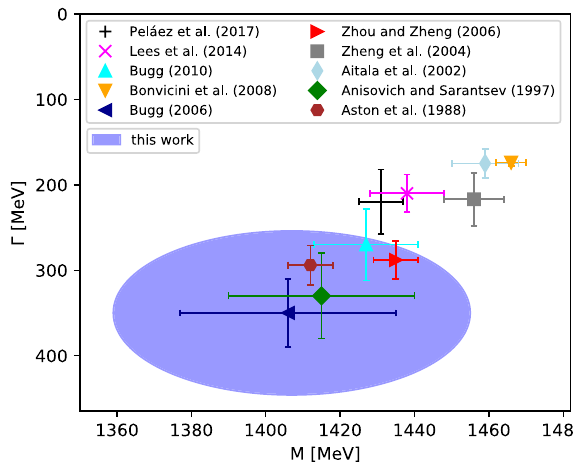
( 1430 ) in comparison to Fig. 12 Extracted pole position of the K ∗ 0 Peláez et al. [5], Lees et al. [95], Bugg (2010) [96], Bonvicini et al. [97], Bugg (2006) [98], Zhou and Zheng [94], Zeng et al. [99], Aitala et al. [100], Anisovich and Sarantsev [93], and Aston et al.